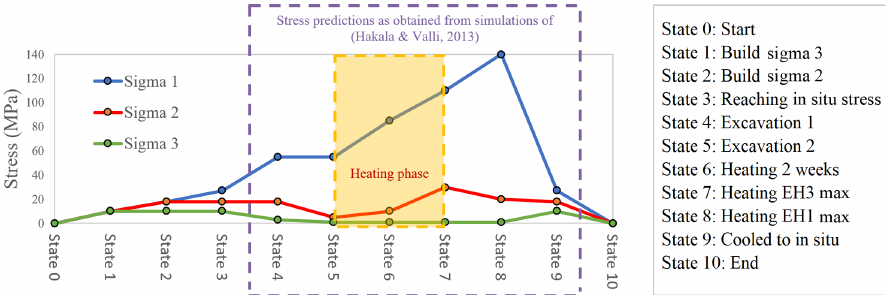
Figure 2. Evolution of the principal stresses at the highest stress zone around the POSE experimental holes. This stress path is the reference stress path imposed on specimens in true-triaxial testing. Table 1. Overview of the systems used in the lab and the field.